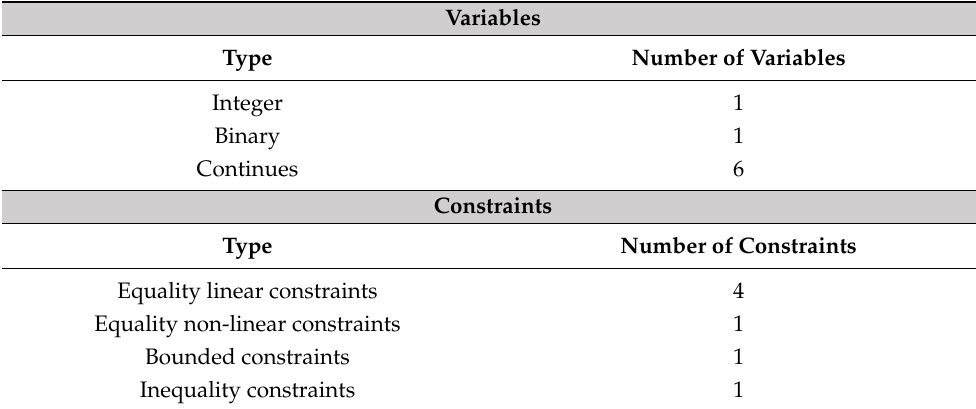
Table 2. Summary of number and types of variables and